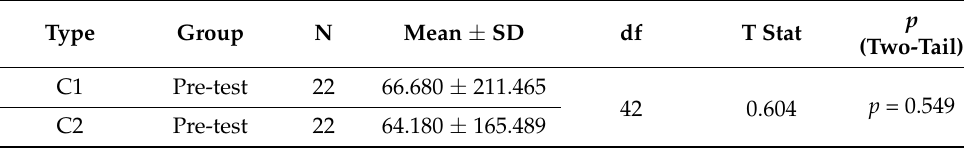
Table 3. Two sample t -Test of the Pre-test Results for C1 and